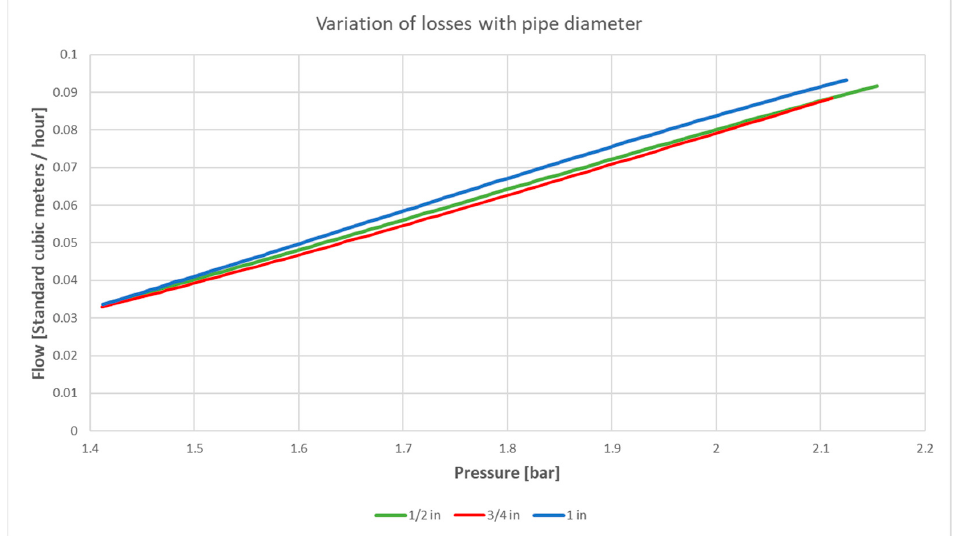
Figure 7. Comparative analysis of flow for different diameters (source: authors based on the ana- lysed data).